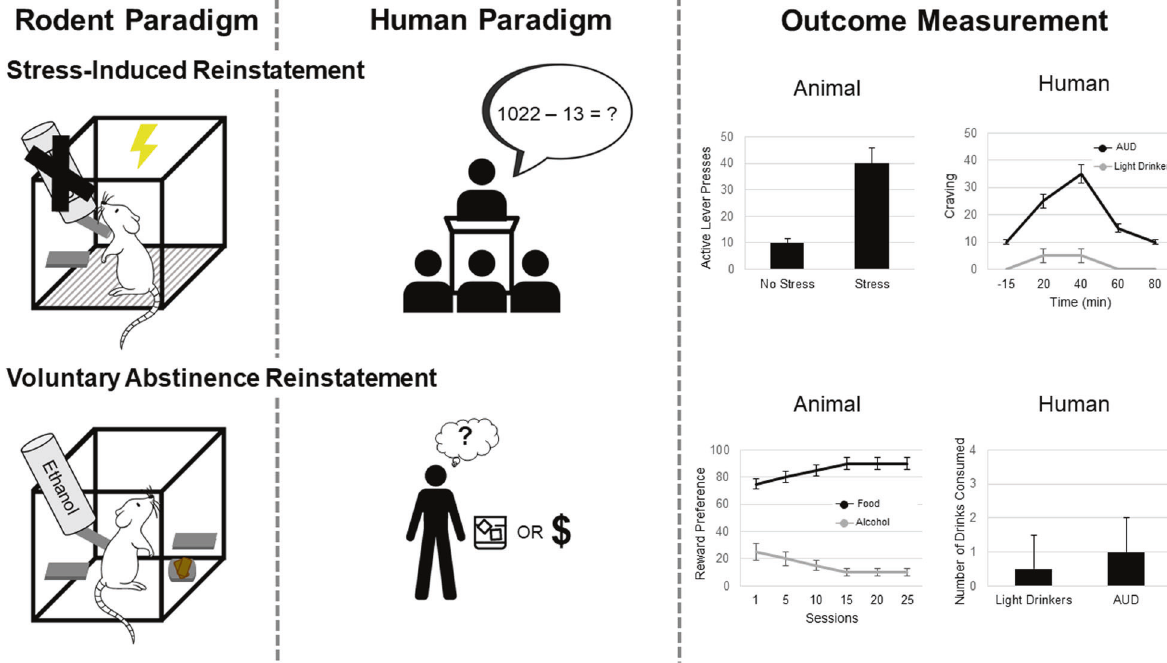
Fig. 4 Depicts rodent and human paradigms and outcome measurement for stress-induced voluntary abstinence reinstatement. The most predominate model of stress induction in rodents is footshock, where a rodent who previously extinguished responding for alcohol returns to alcohol seeking after exposure to footshock stress. In humans, one common paradigm to induce alcohol craving is the Trier Social Stress Task, during which participants must deliver a speech and perform mental arithmetic in front of an unsupportive audience. To model voluntary abstinence in rodents, animals that have been trained to self-administer both food and drugs are given daily mutually exclusive choice trials between a drug and a palatable food. Preference for food or alcohol is used to measure the choice for alcohol over alternate rewards. In humans, voluntary abstinence can occur in the presence of alternative rewards, such as a maintaining a job, relationships, and